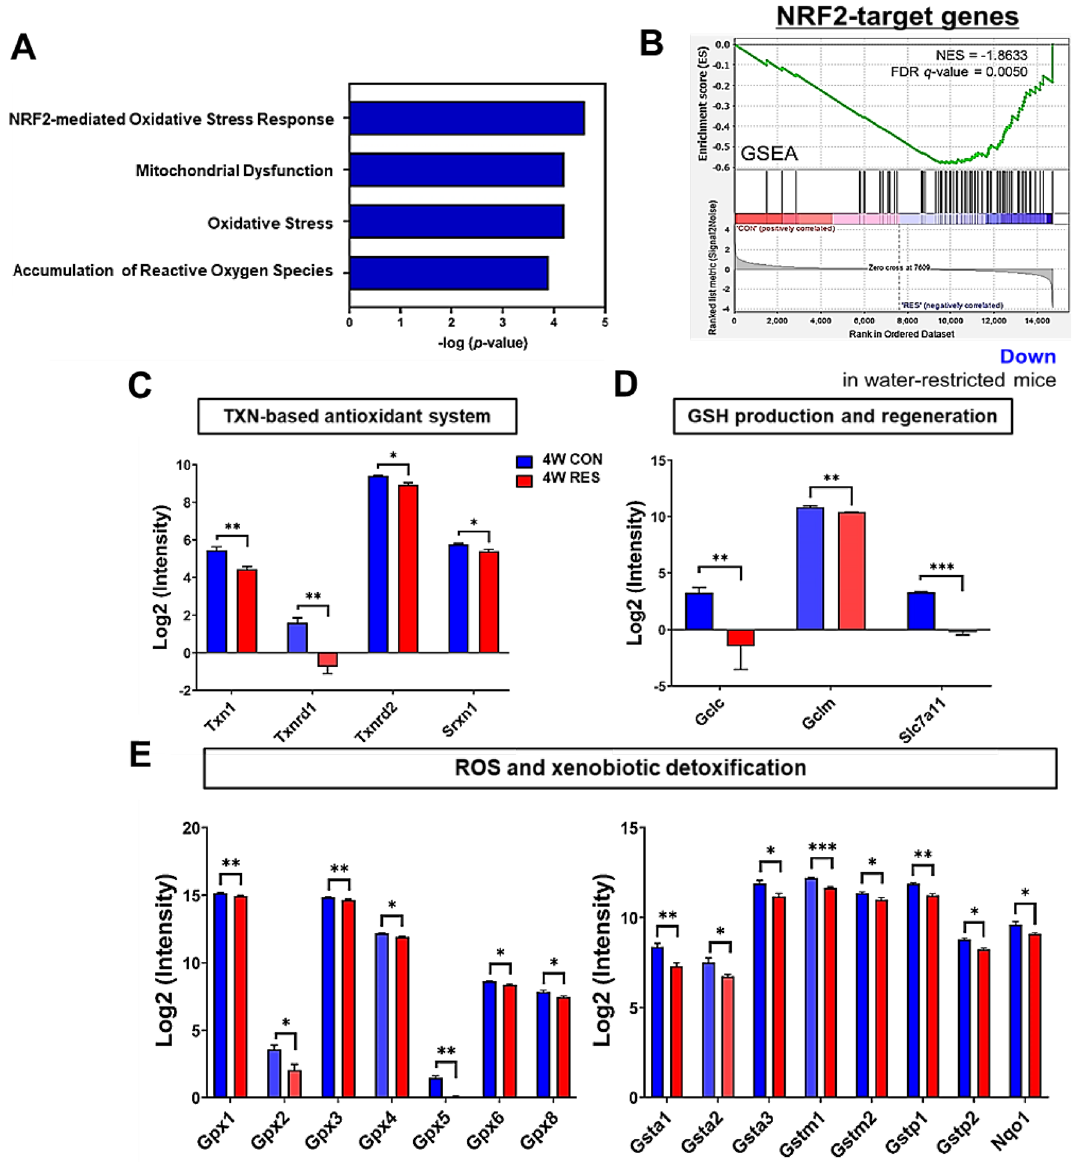
Figure 5. Prolonged dehydration exacerbates kidney damage by suppressing the NRF2-signaling pathway in mice. ( A ) Canonical pathway of gene sets among differentially expressed genes significantly detected in dehydrated compared to control mice. Statistical significance of pathway modulation was calculated via a right- tail Fisher’s exact test in Ingenuity Pathway and represented as –log( p value). ( B ) Gene set enrichment analysis (GSEA) was used to evaluate the most significant functional category of differentially expressed genes by dehydration in mice and generate enrichment plot of NRF2-target genes. ( C – E ) Bar graphs show the expression of downstream target genes of the NRF2-signaling pathway. ( C ) TXN-based antioxidant system, ( D ) GSH production and regeneration, and ( E ) ROS and xenobiotic detoxification are regulated by the NRF2-signaling pathway. Data are expressed as mean ± SEM. Statistical significance was calculated using a two-tailed Mann– Whitney test. * p < 0.05, ** p < 0.01, *** p <